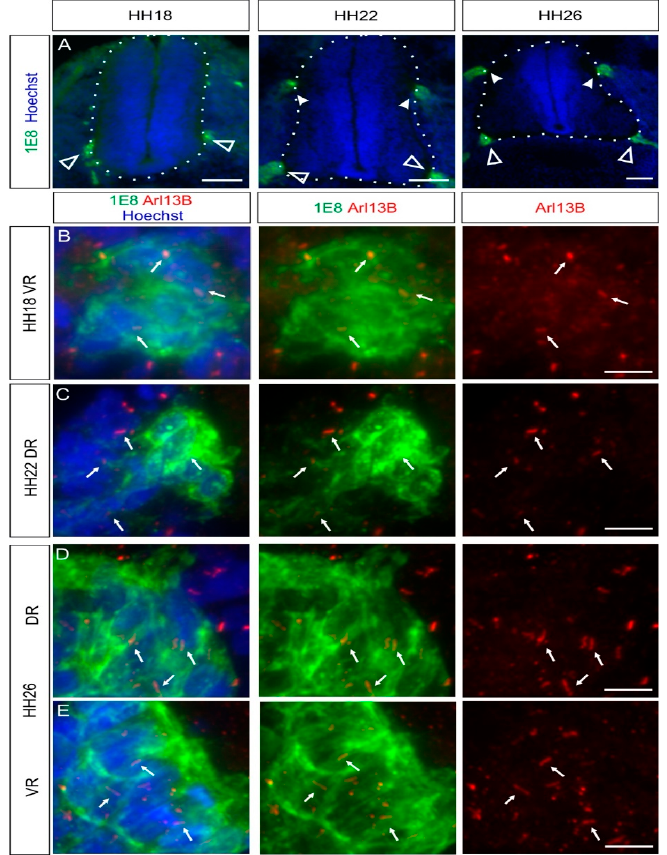
Figure 3. BCCs possess a primary cilium during the early development of the central nervous system (CNS)–peripheral nervous system (PNS) boundary. BCCs were stained with 1E8 antibodies (green) and primary cilia with Arl13B antibodies (red). ( A ) BCC clusters were initially detected at the ventral roots at HH18 (white open arrowheads). BCC clusters at the dorsal roots were observed at HH22 (white arrowheads). Nuclei were counterstained with Hoechst (blue). ( B – E ) BCCs were ciliated at both dorsal and ventral roots between HH18 and HH26 (white arrows). White dashed lines represent the boundary of the spinal cord (CNS). DR, dorsal roots; VR, ventral roots. Dorsal is up. Scale bars: 100 ( A ) and 10 µ m ( B – E